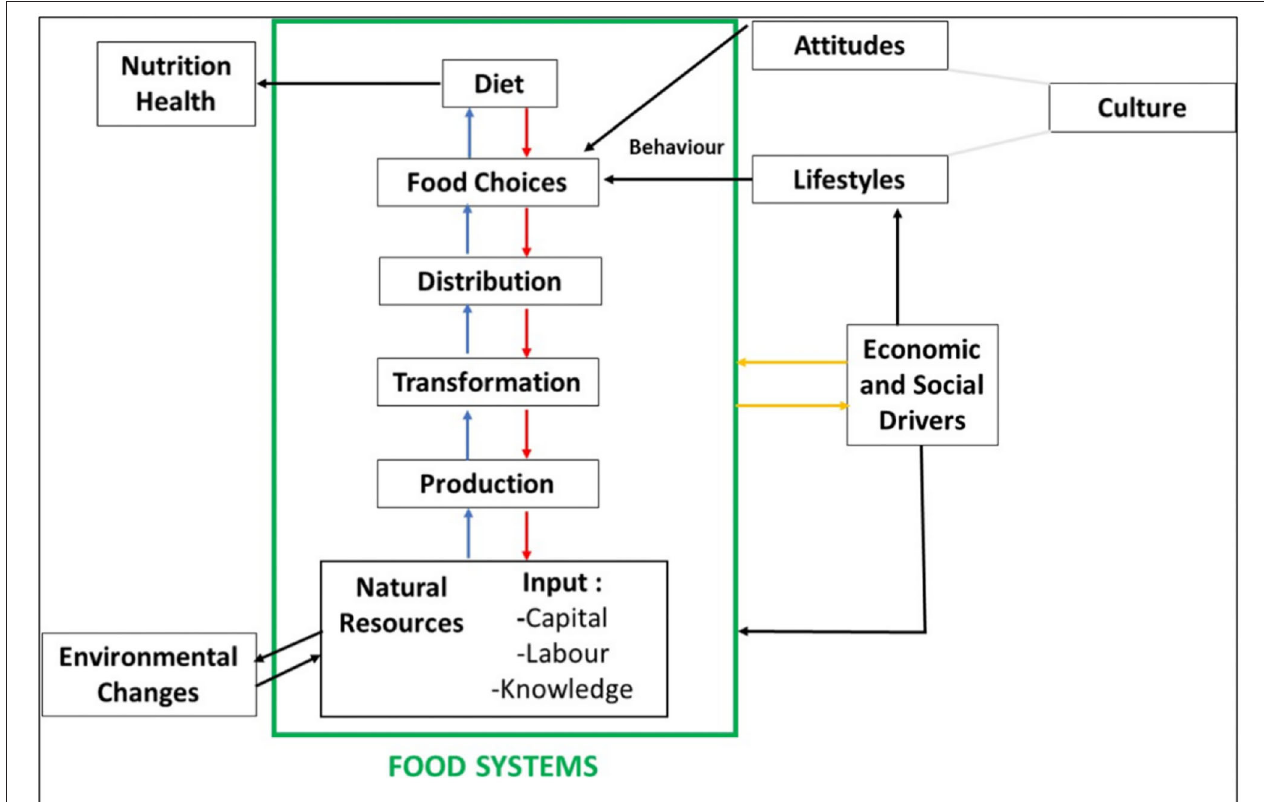
FIGURE 1 | Food systems and diets (Source: Meybeck and Gitz,